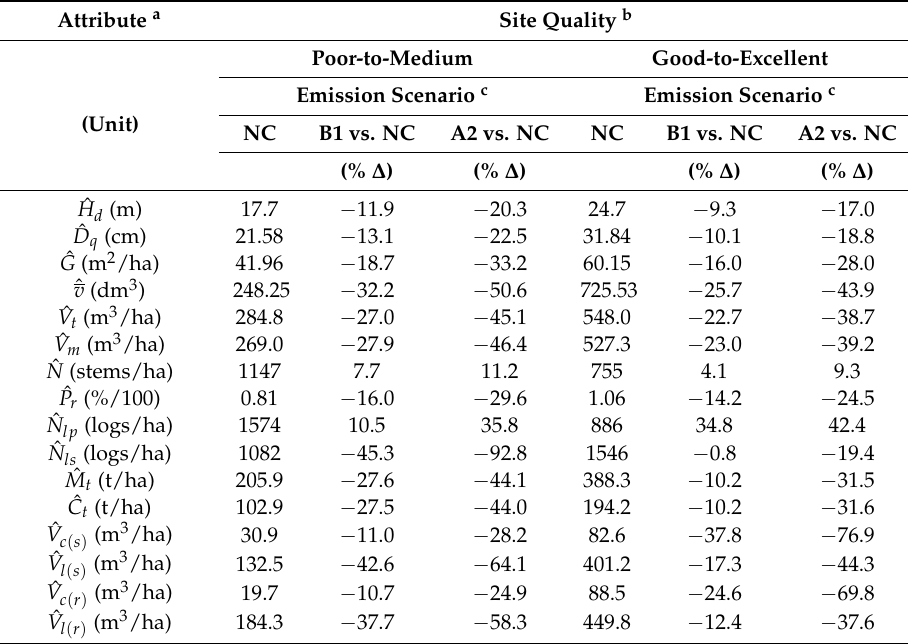
a–c : As defined in Table A1 table notes.